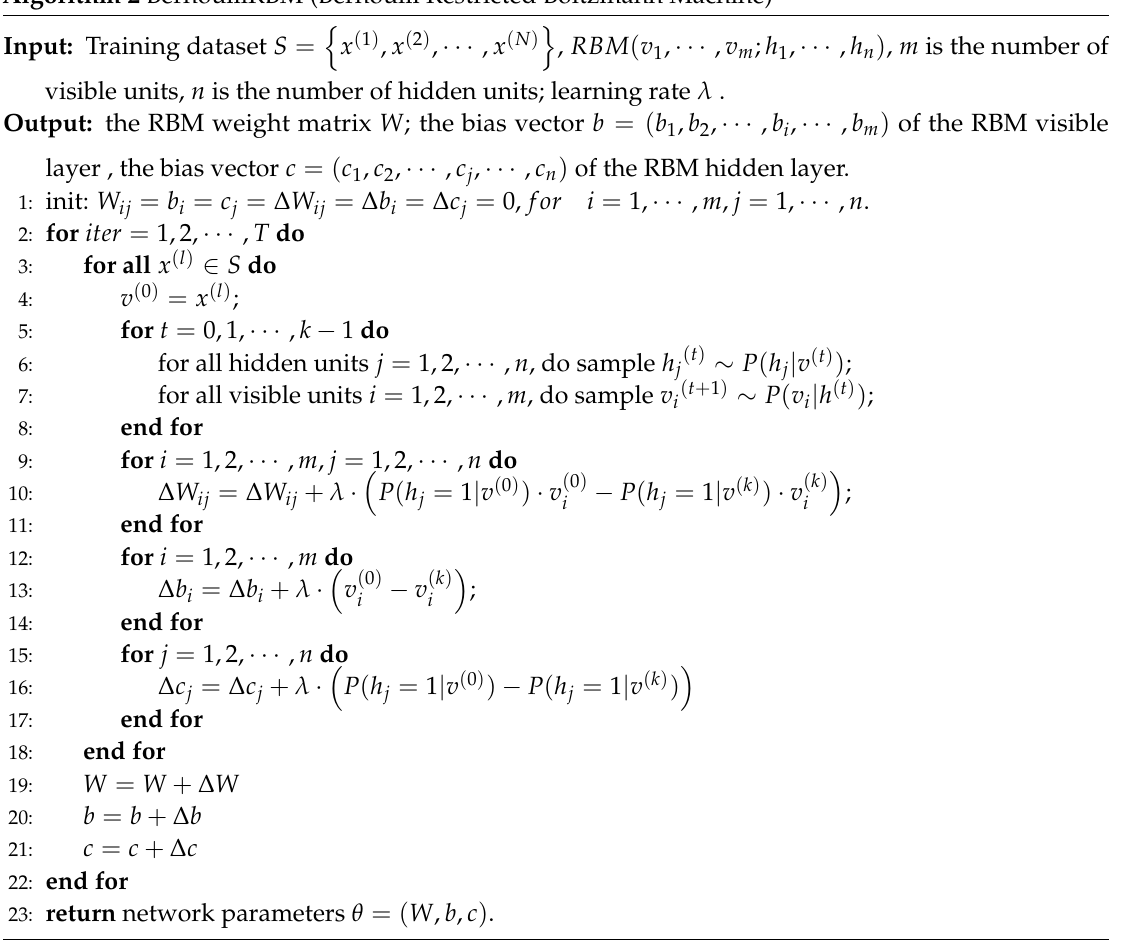
Algorithm 2 BernoulliRBM (Bernoulli Restricted Boltzmann